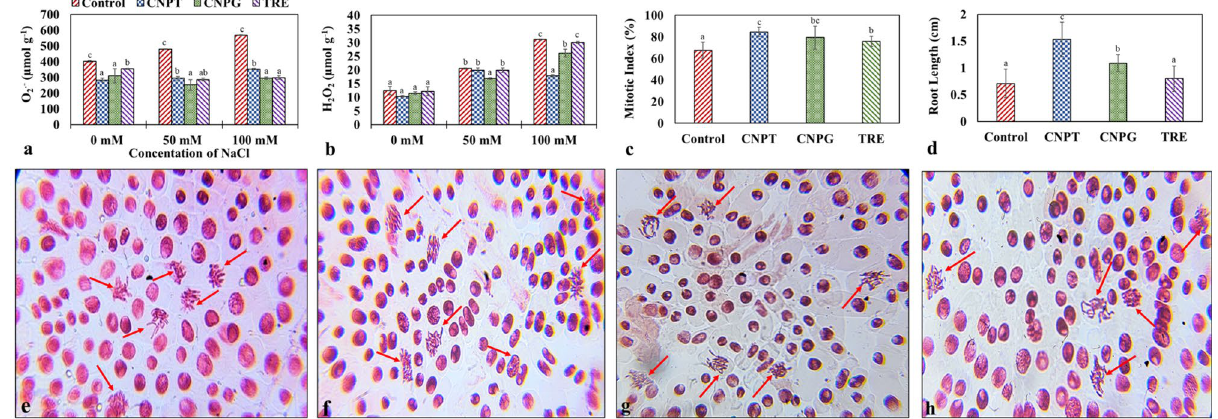
Figure 6. Changes in ROS accumulation of NaCl stressed Vigna radiata seedlings following the application of CNPT, CNPG and TRE, and Allium cepa root tip bioassay. ( a ) O 2 · − content (μmol g −1 f.w.t), and ( b ) H 2 O 2 content (μmol g −1 f.w.t) of saline stressed Vigna radiata seedlings; ( c ) Mitotic index (%) of Allium cepa root tip; ( d ) Root length of Allium cepa ; ( e - h ) Microscopic cellular images of Allium cepa root tip treated with dH 2 O, CNPT, CNPG, and TRE solutions respectively. Red arrows ( e – h ) point out the healthy dividing